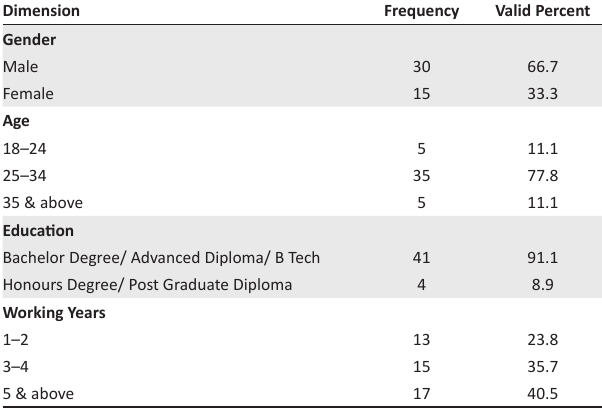
TABLE 1: Demsographic profile of